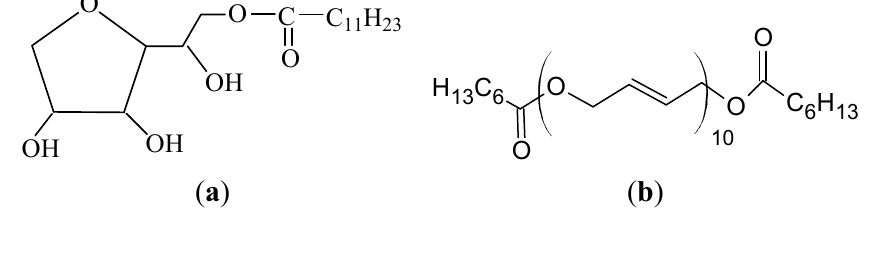
Figure 1. Molecular structure of anti-agglomerant used in this work: ( a ) Span 20; ( b ) esters